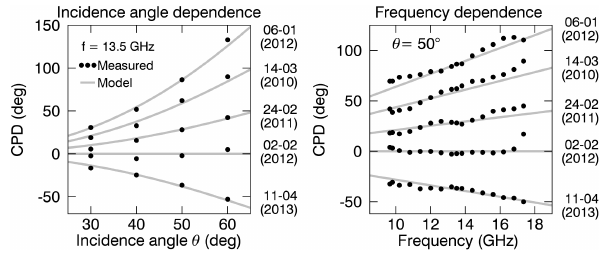
Figure 12. Left panel: incidence angle dependence of measured CPD vs. modeled incidence angle dependence. Right panel: fre- quency dependence of measured CPD vs. modeled linear frequency